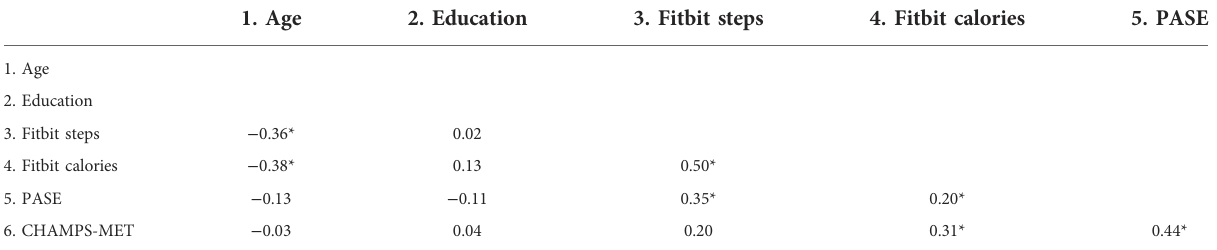
TABLE 2 Correlations between physical activity measures, age, and education. 1.